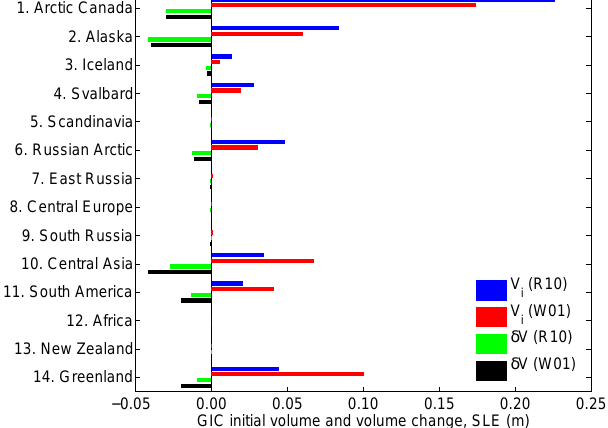
Fig. 9. GIC initial volume ( V i ) and volume change per region ( δV ), SLE (m).